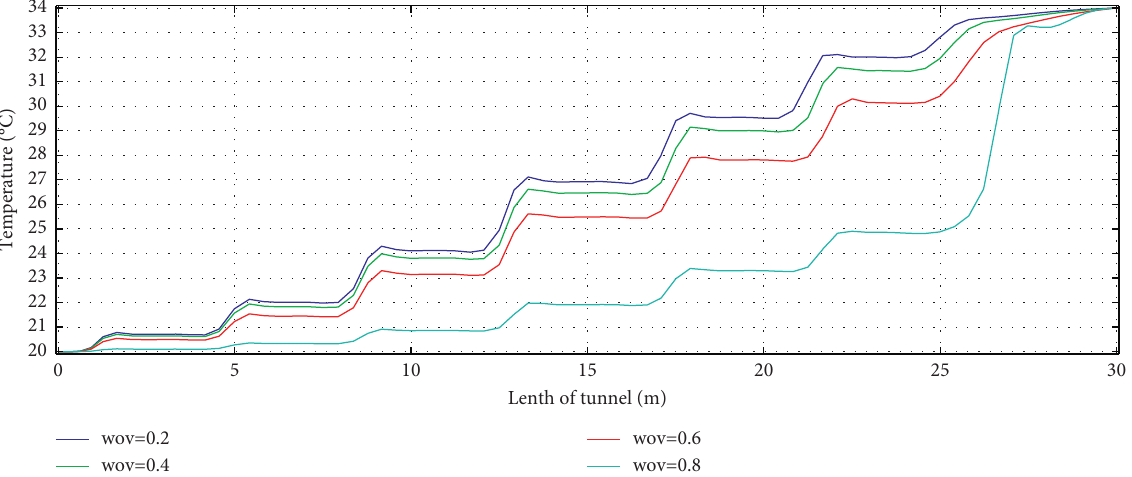
Figure 11: Air temperature distribution inside the tunnel under different humidity.